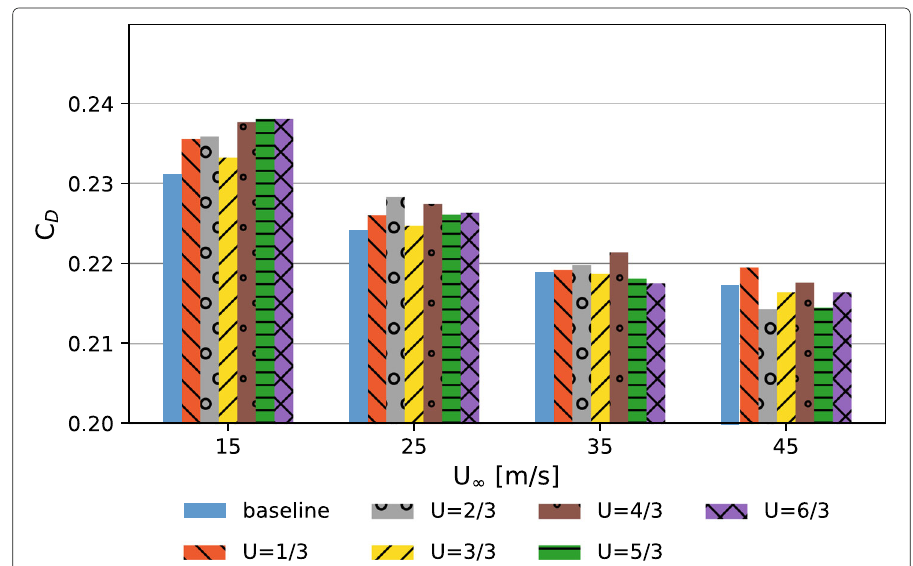
Fig. 19 Time-averaged drag coefficient for the notchback DrivAer model with 45 ◦ air-jet wheel deflectors